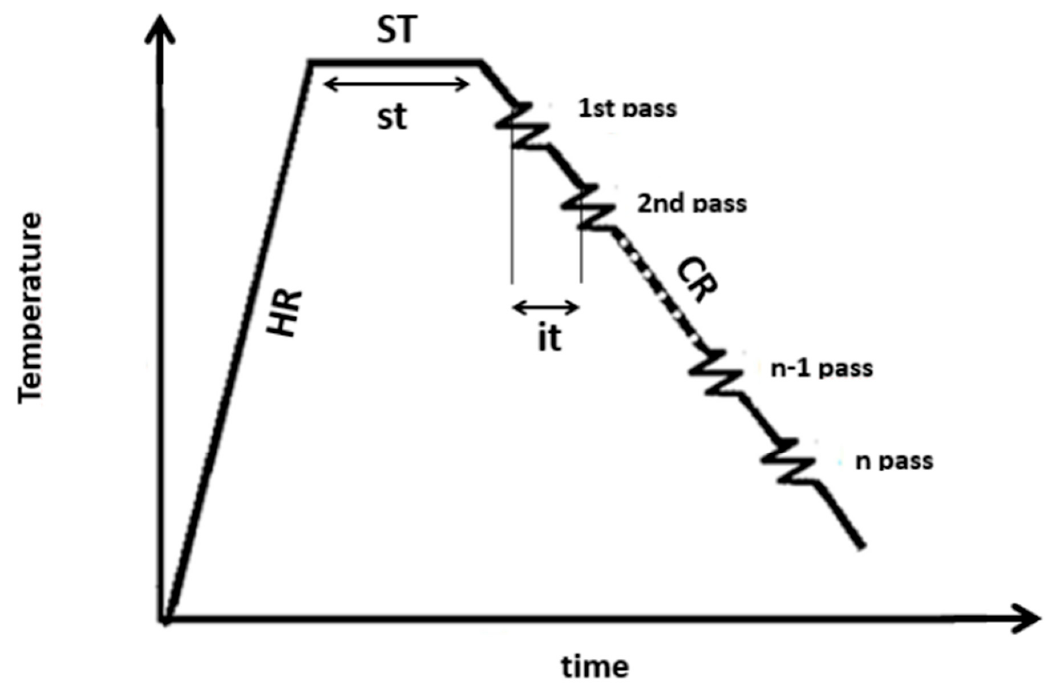
Figure 1. Sketch of the thermomechanical schedule: heating rate (HR): 2.0 ◦ C s − 1 , soaking temperature (ST): 1200 or 1250 ◦ C, soaking time (st): 300 s, interpass time (it): 50, 20, or 5 s, and cooling rate (CR): 24, 60, and 240 ◦ C min − 1 . The cooling rate was selected to ensure that the deformation temperature was the same at each interpass